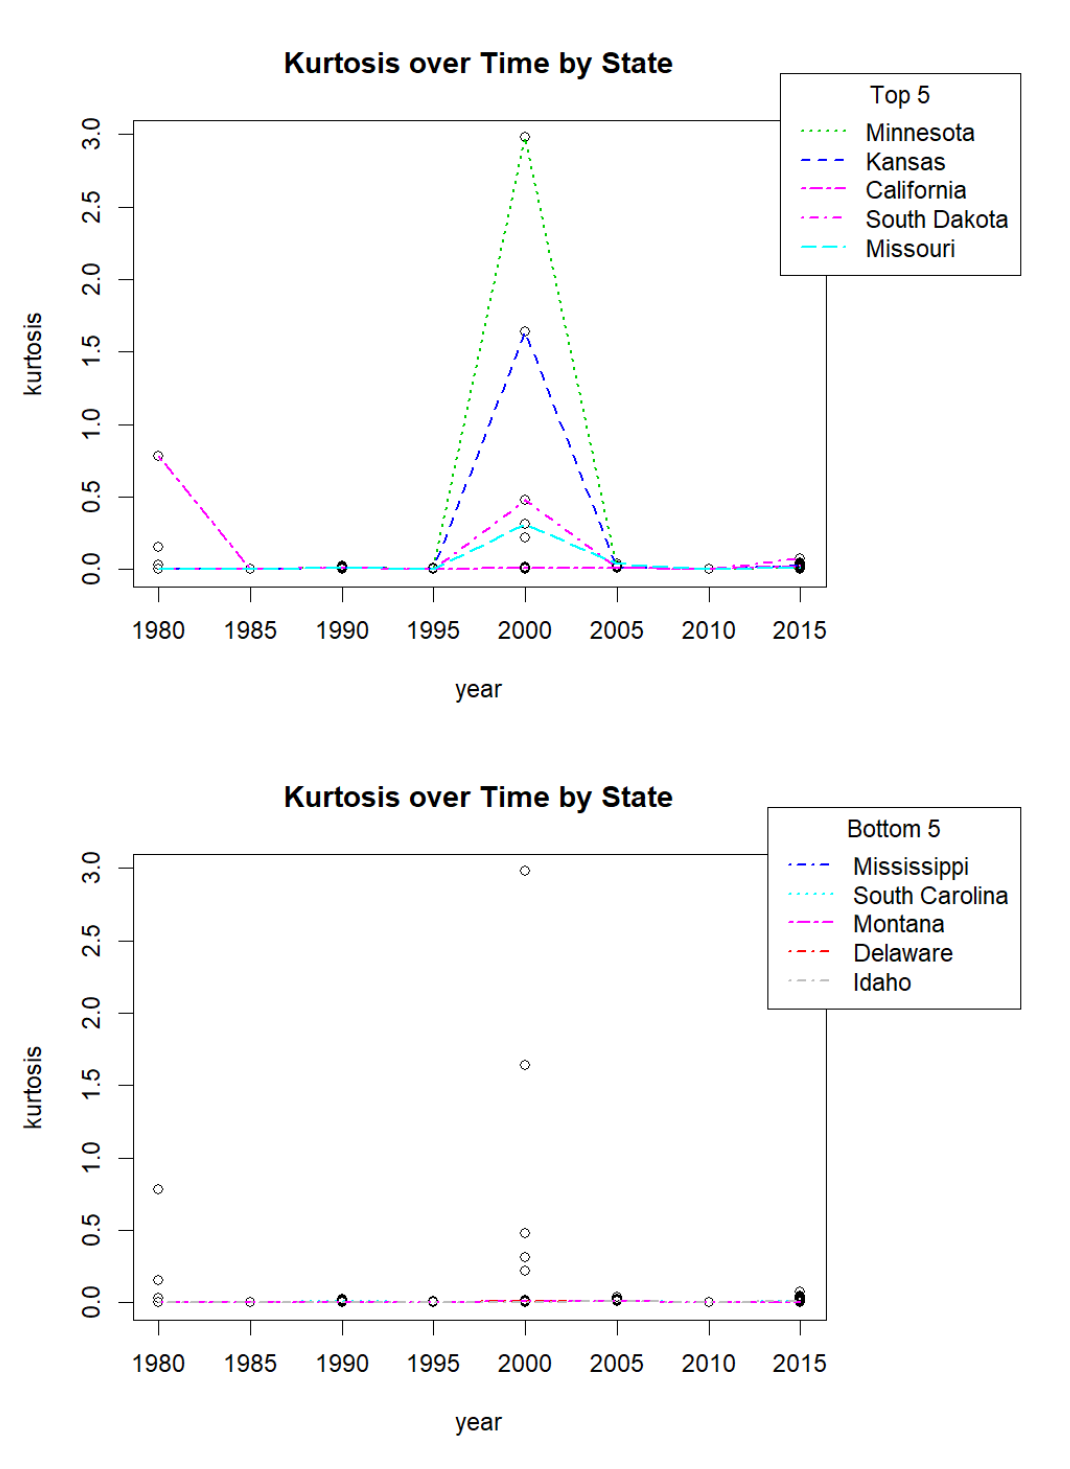
Figure 7. Kurtosis top 5 and bottom 5. Figure 8 plots the higher moments against the expected rate of returns to schooling (mean). For each row of plots, the right panel is a zoom-in of the left panel (i.e., excludes more extreme values). Plotting the expected returns against their variances (top two panels) yields an unsurprising result: the higher the variance of the distribution of rate of returns to schooling, the higher the mean of